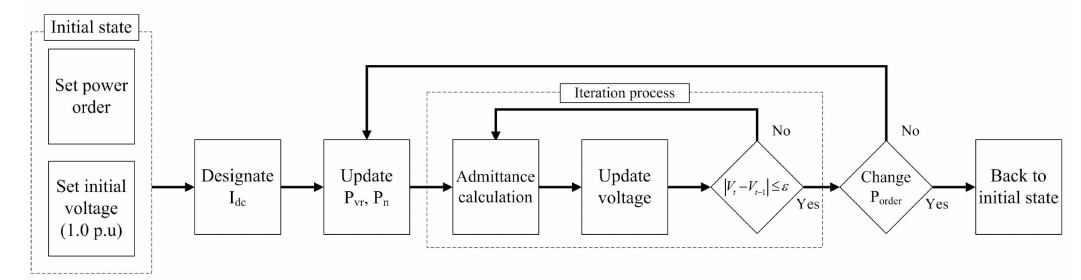
Figure 7. Power flow analysis algorithm of wave system including VR.